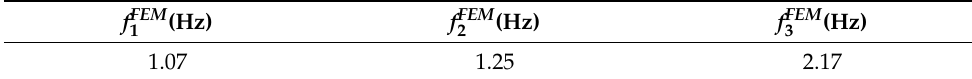
Table 9. Numerical natural frequencies.